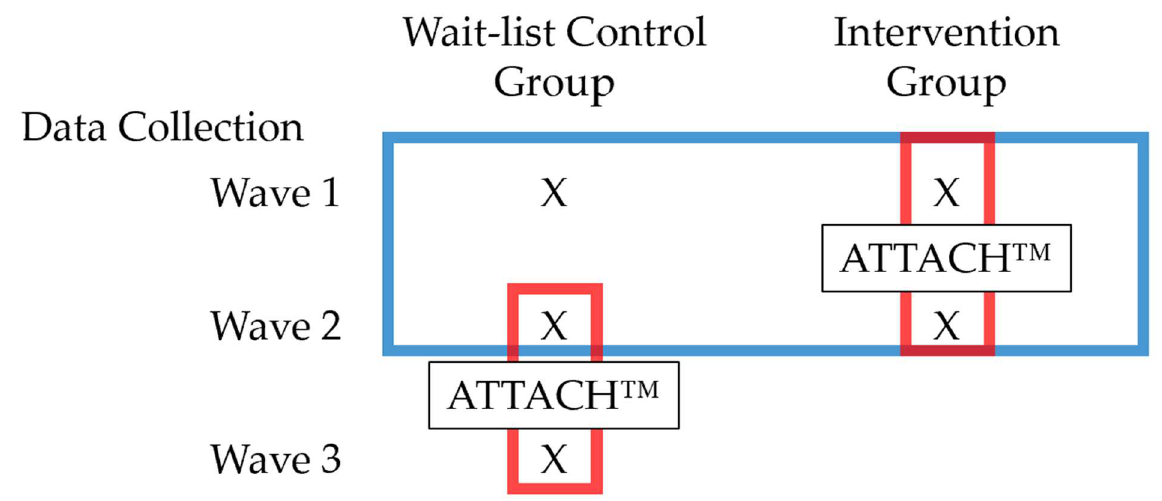
Figure 1. Schematic of data collection. Both intervention and wait-list control groups completed a baseline measurement (Wave 1). The intervention group completed the ATTACH™ Intervention between Wave 1 and Wave 2. Both the intervention and wait-list control groups completed an assessment after the intervention group completed the program (Wave 2). The wait-list control group then completed the ATTACH™ Intervention between Wave 2 and Wave 3. The wait-list control group completed another wave of assessment after the intervention was completed (Wave 3). The blue box indicates data points that were included in between-person analyses (intervention vs. control group, RCT). The red boxes indicate data points that were included in within-person analyses. (pre-to-post intervention change; QES).